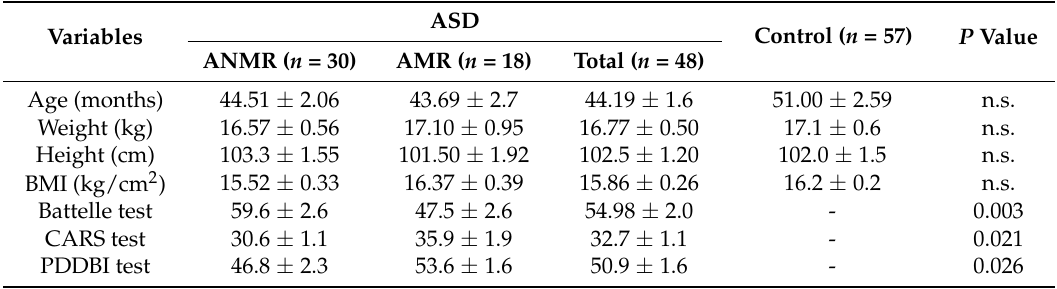
Table 1. Descriptive characteristic of autism spectrum disorder and healthy children participants. Variables